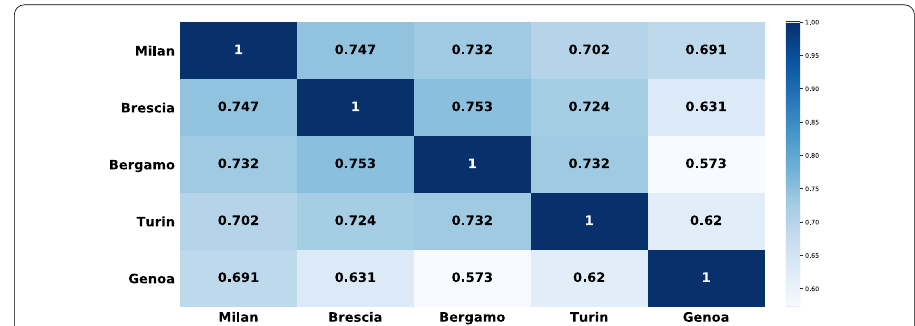
Fig. 5 Matrix of the city consumption similarity index. Rows and columns report the five selected city. Each element of the matrix denotes the weighted Kendall’s coefficient computed on the rank induced by the city consumption